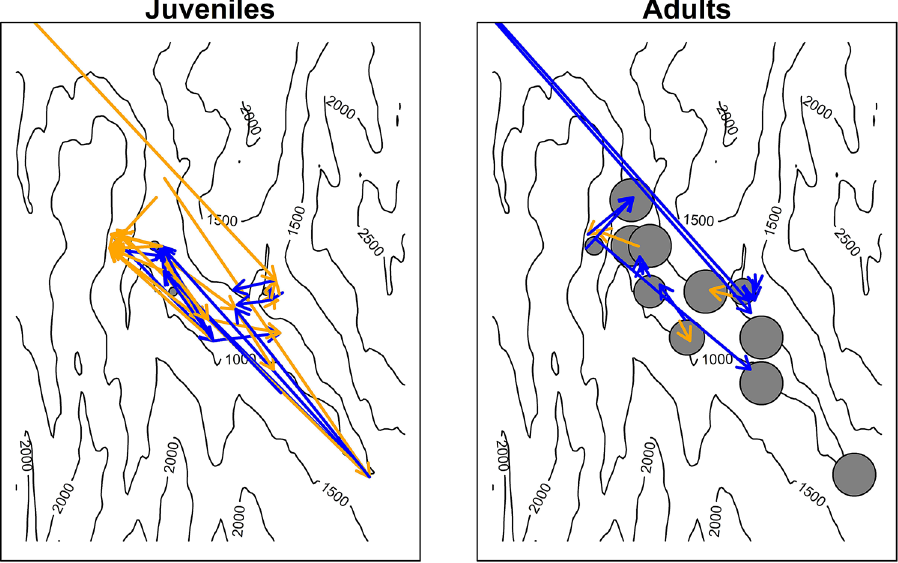
Figure 3. Study area. Sites with non-dispersers (grey circles, the larger the circle the larger the proportion of non-dispersers) and dispersal events (blue arrows: downwards dispersal; orange arrows: upwards dispersal) for juveniles (left panel) and adults (right panel) are shown. N = 126 recaptures of 89 individuals.